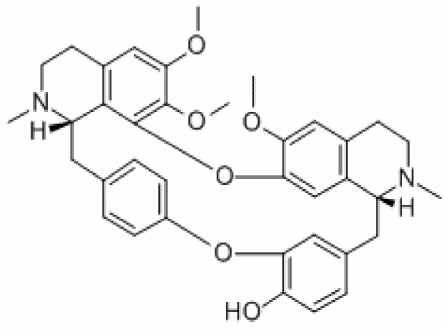
Figure 6. Chemical structure of